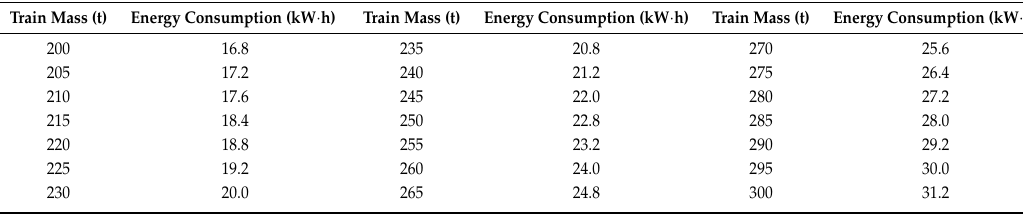
Table 7. Energy consumptions with different train masses.